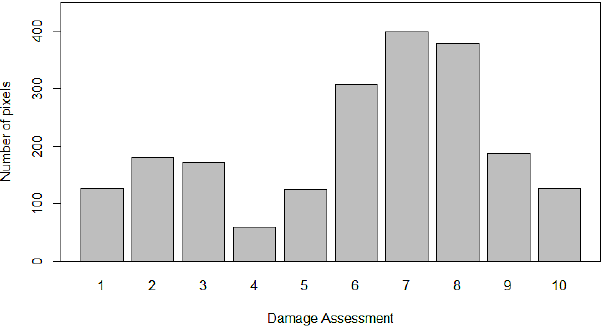
Fig. 5. Classification of damage within FEMA surge extent using non-authoritative